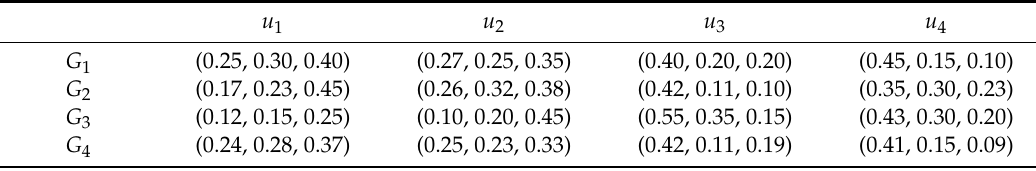
Table 1. Petroleum circulation center information.